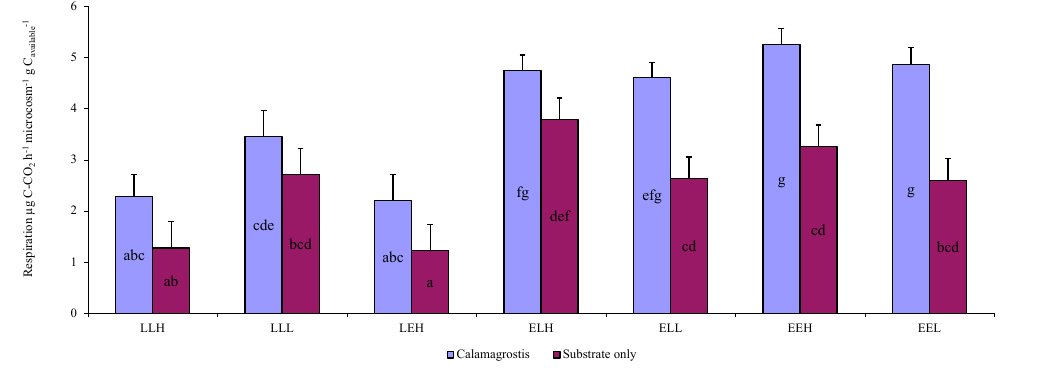
Figure 5. Average respiration of individual treatments with the addition of litter Calamagrostis epigejos (Calamagrostis) or without the addition of litter (Substrate only) for the whole experiment time related to the amount of available carbon (C-CO 2 h − 1 microcosm − 1 g C available − 1 ). Error bars are standard deviation. Results are based on repeated measurement ANOVA. If ANOVA was significant for soil type, the results of the post hoc test are given (Fischer LSD, p < 0.05). Homogeneous statistical groups are indicated by the same letters.